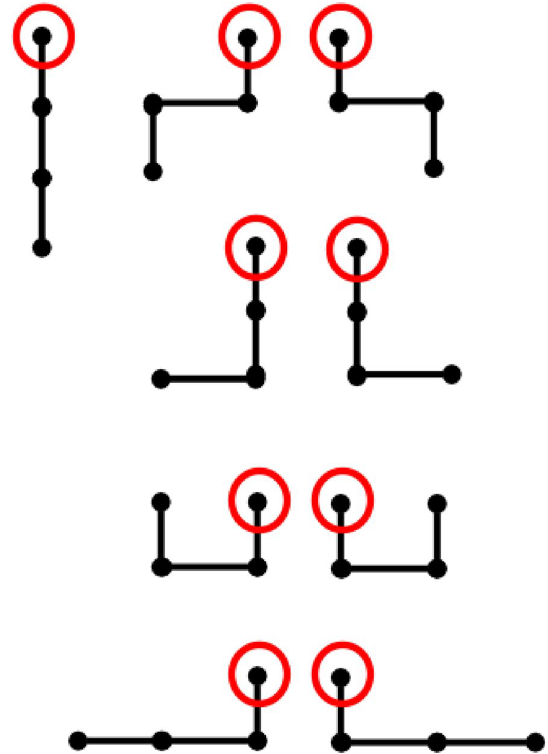
Fig. 17 CONTIGUOUS RANDOM WALK: Destination pixel marked in RED and last-mile entry is from the bottom pixel (i.e. pixel located below the final destination